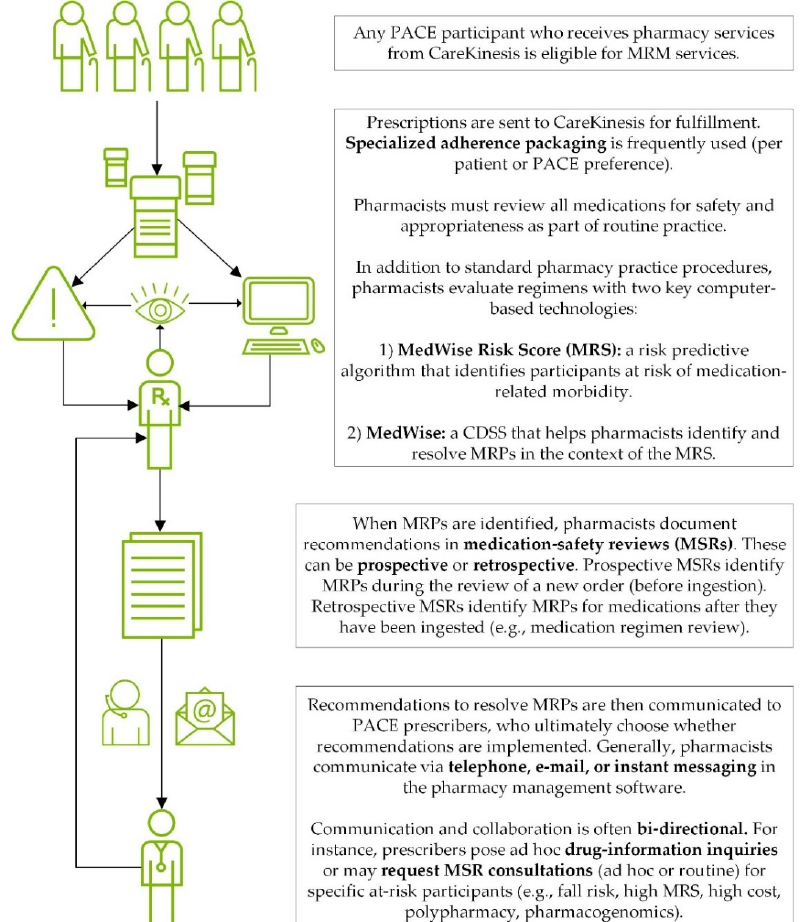
Figure 1. MRM workflow. Abbreviations: CDSS = clinical decision support software; MRM = medication risk mitigation, MRP = medication-related problem; PACE = The Program of All-Inclusive Care for the